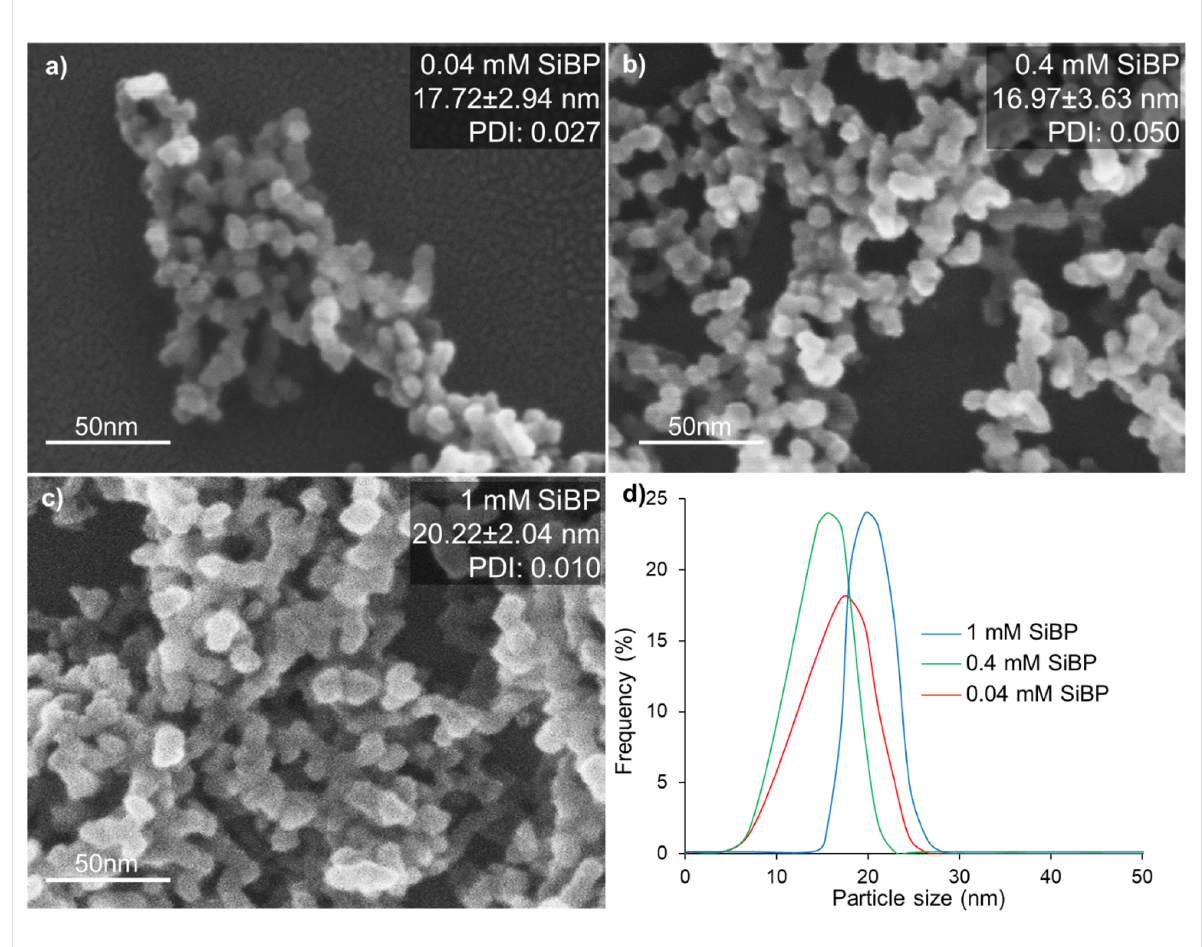
Figure 2: SEM images of the SiO 2 particles formed by SiBP alone at concentrations of (a) 0.04 mM, (b) 0.4 mM, and (c) 1 mM. (d) Particle size fre- quency distributions obtained from DLS measurements.